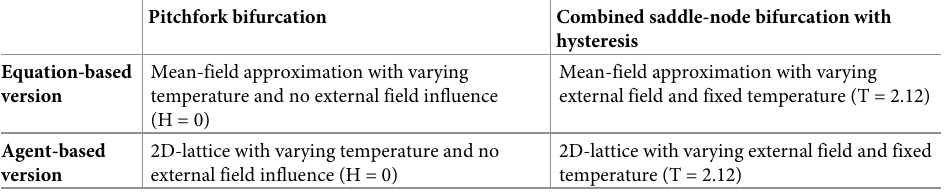
hysteresis Mean-field approximation with varying external field and fixed temperature (T = 2.12)